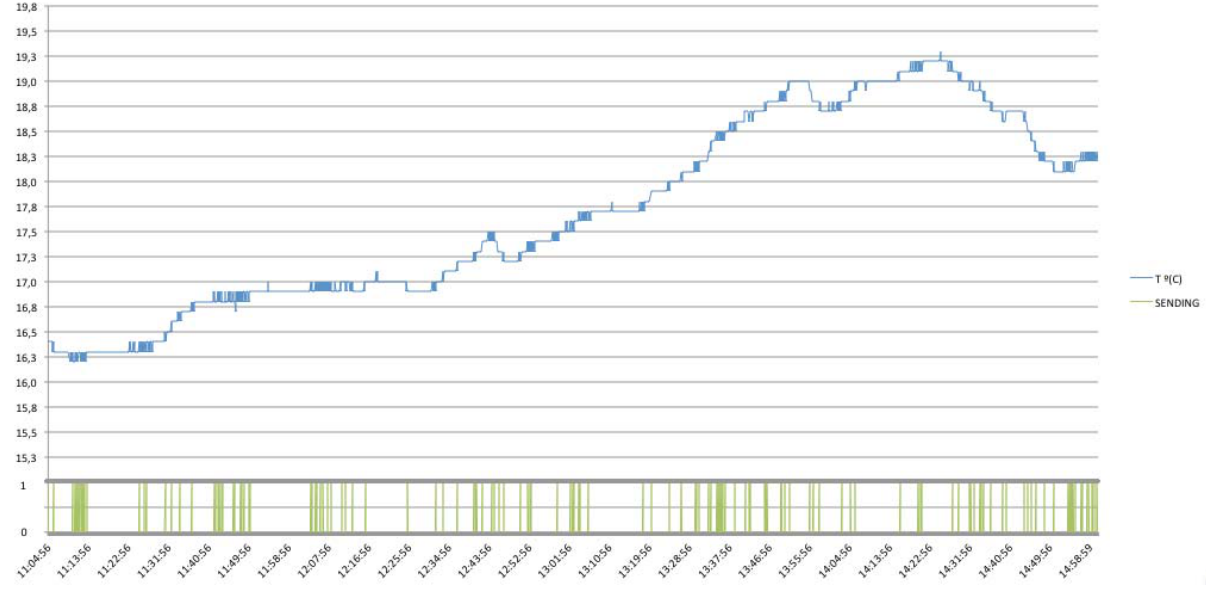
Figure 31. Notifications with Observe Conditional, Minimum Response Time option set to 15